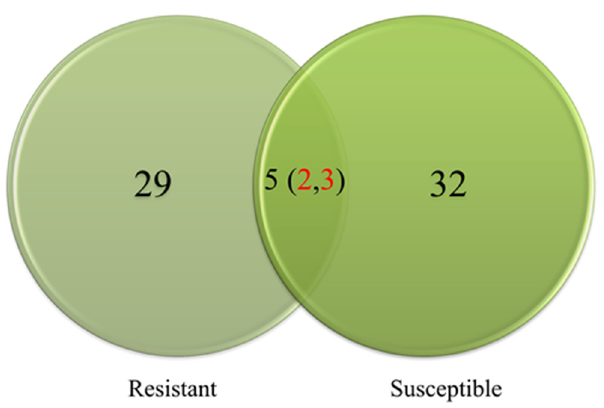
Figure 3. Number of metabolites accumulated in resistant and susceptible genotypes. Numbers in the parenthesis indicate upregulated (red) and downregulated metabolites (black). A total of 66 bio-molecules representing 32 functional classes were expressed. The RM and SM expressed 29 and 32 exclusive metabolites, respectively. Of the five common metabolites, three were